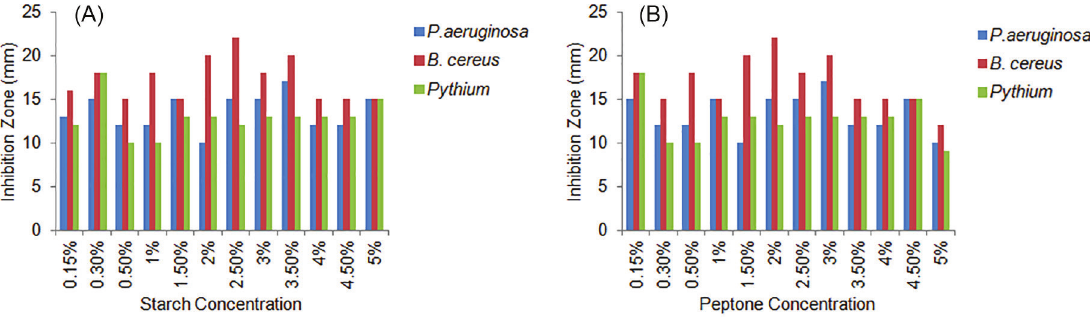
FIGURE 4 - The effect of starch and peptone compositions on the antimicrobial activity of B. amyloliquefaciens DSM7 against different pathogens.